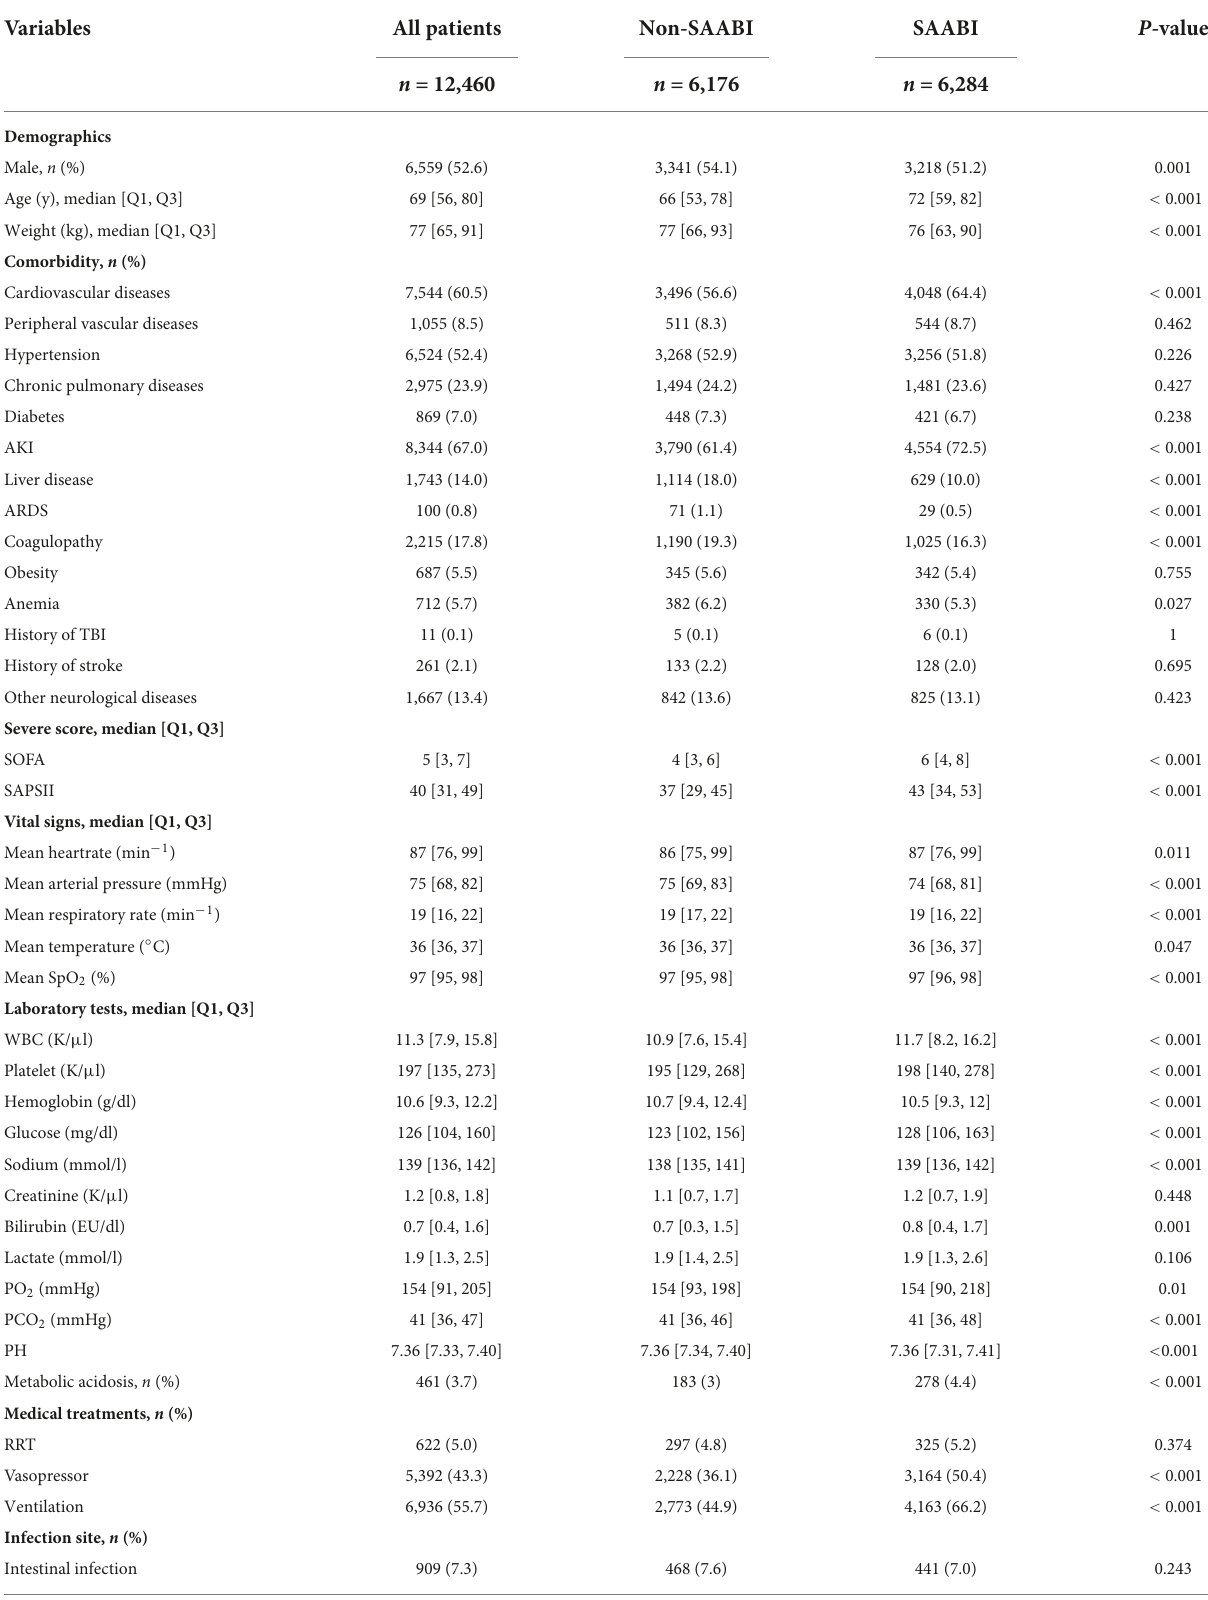
TABLE 1 Baseline characteristics of patients at ICU